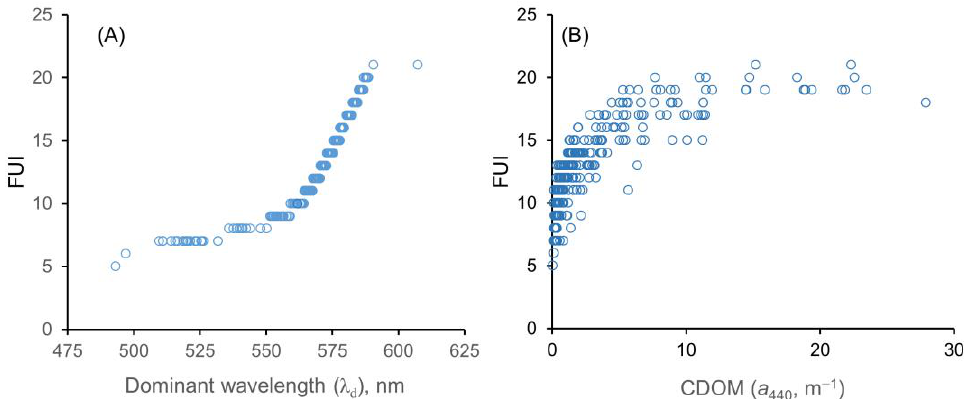
Figure 8. Relationships between some water quality metrics and λ d,hyp : ( A ) Secchi depth; ( B ) CDOM; ( C ) CHL.